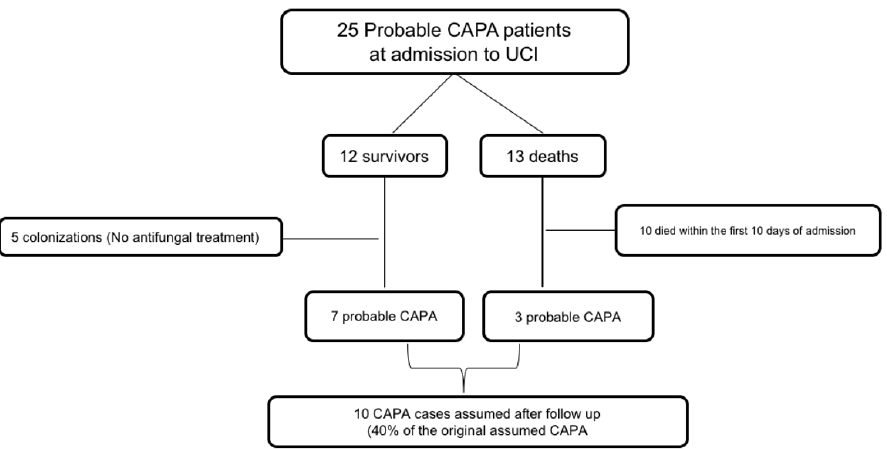
Figure 1. Flowchart showing assumed CAPA patients during admission and CAPA patients confirmed after follow-up.